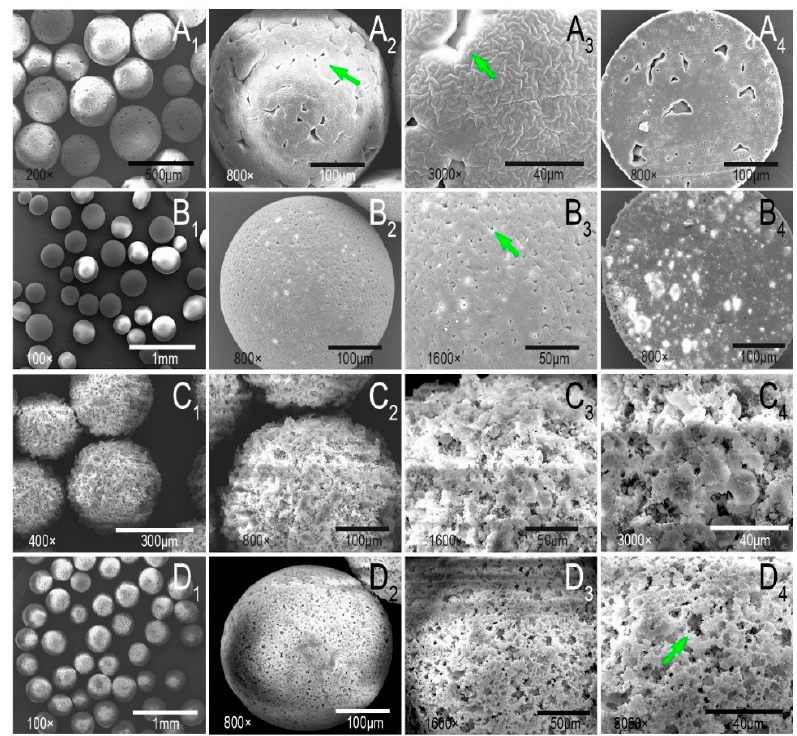
Figure 3. ( A 1 – A 3 ): The surface morphology of PLLA microcarriers; ( B 1 – B 3 ): The surface morphology of PLLA/nHA microcarriers; ( A 4 , B 4 ): The cross-sectional morphology of PLLA and PLLA/nHA microcarriers; ( C 1 – C 4 ): The surface morphology of PLLA/nHA microcarriers after alkaline treatment of 10 min; ( D 1 – D 4 ): The surface morphology of PLLA/nHA/Ch microcarriers coated with chitosan.